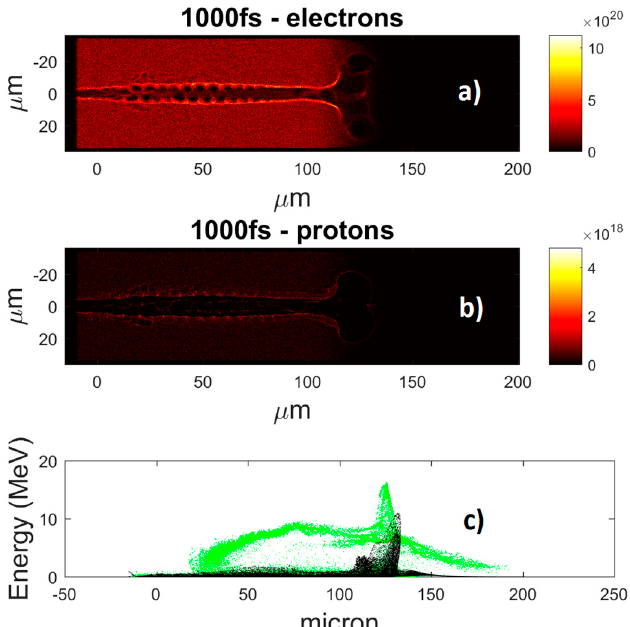
Figure 4. Snapshots of the 2D PICs after 1000 fs from the laser pulse entry in the simulation box of a fully-ionized 95% Xe–5% H plasma mixture at a flat density of 2 × 10 20 e − / cm 3 for a comparison with the case of Figure 2 (right). The electrons’ (frame a ) and protons’ (frame b ) density distributions are shown for both cases together with the protons’ (black) and electrons’ (green) energies along the laser propagation direction (frame c ). An energy increase of about a factor 2 is evident with respect to the pure hydrogen plasma case (Figure 2-right).